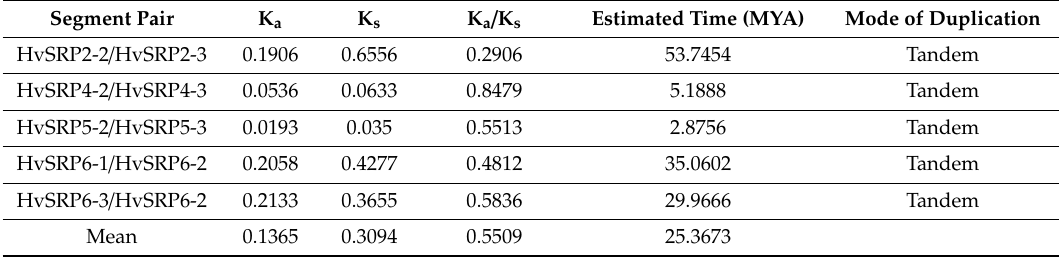
Table 4. The K a and K s values and estimated divergence time for tandemly duplicated HvSRP genes. Segment Pair K a K s Estimated Time (MYA)